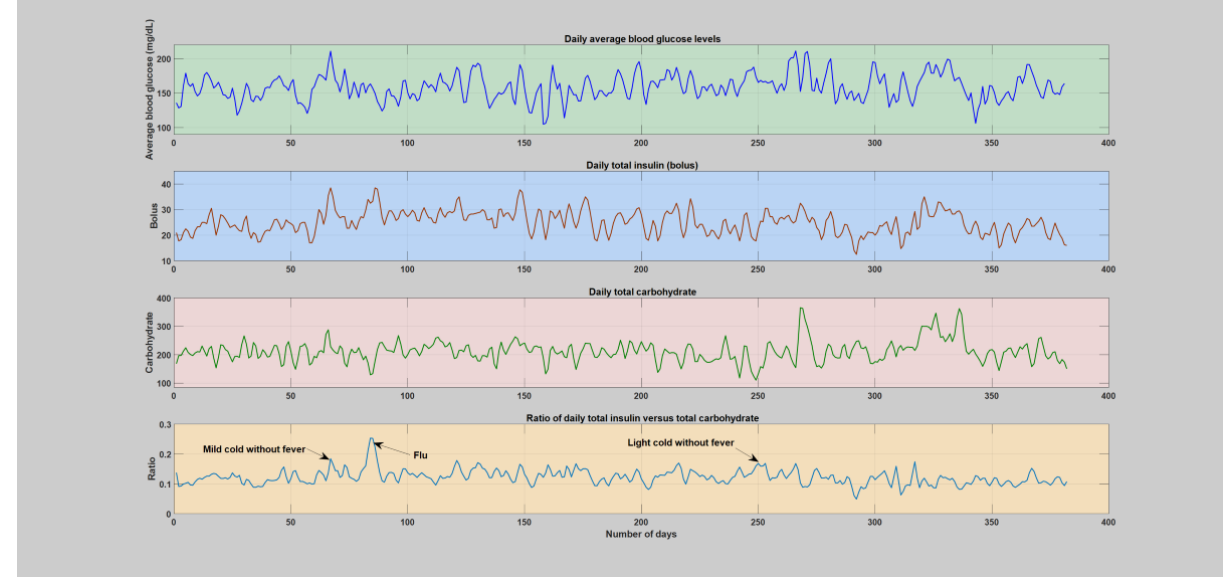
Figure 10. Daily analysis of the fourth infection case (mild common cold without fever, light common cold without fever, and flu). The figure depicts variation of average blood glucose levels, total insulin (bolus), total carbohydrate, and total insulin-to-total carbohydrate ratio. The operating point of the patient’s insulin-to-carbohydrate ratio had dramatically shifted and raised above the regular or normal days and reach a top around 0.28 upon midinfection week. A light common cold without fever seems to not significantly affect the operating point.